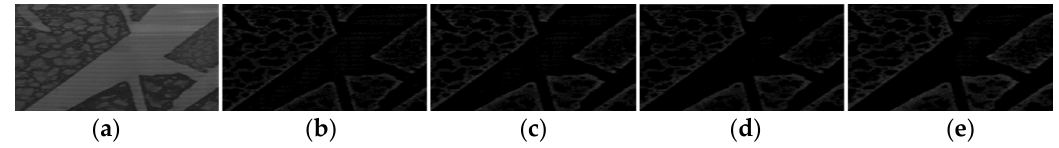
Figure 15. Cropped DoG results with di ff erent window sizes: ( a ) Original image; ( b ) DoG image with window size (ws) 25; ( c ) DoG image with ws 35; ( d ) DoG image with ws 45; ( e ) DoG image with ws 55.